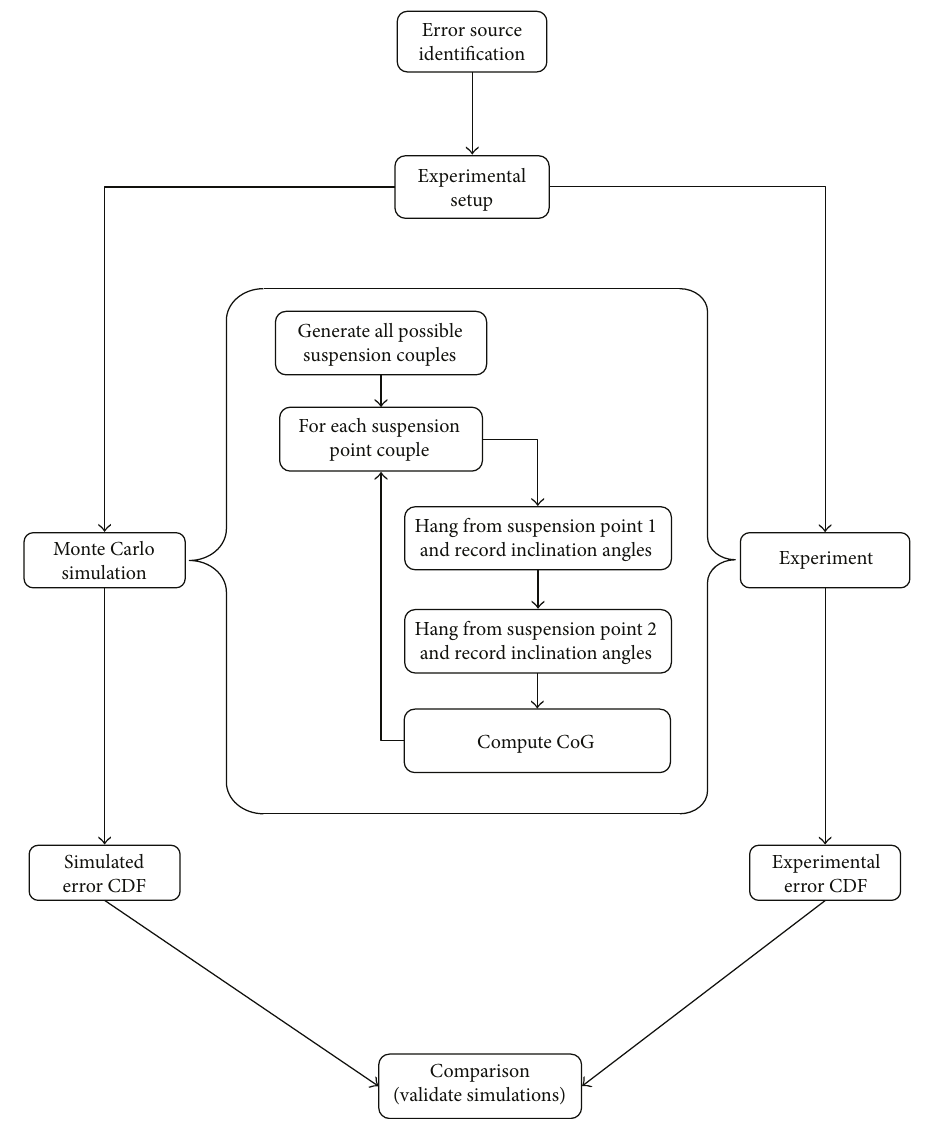
Figure 6: Work fl ow diagram of the validation process for the double suspension method. Table 1: Suspension point